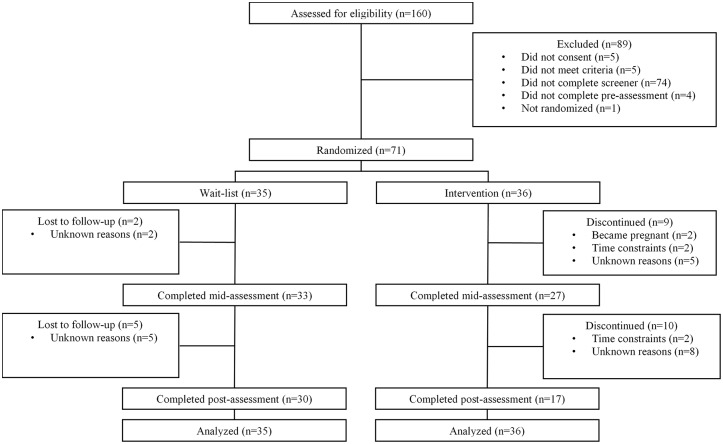
CONSORT diagram.